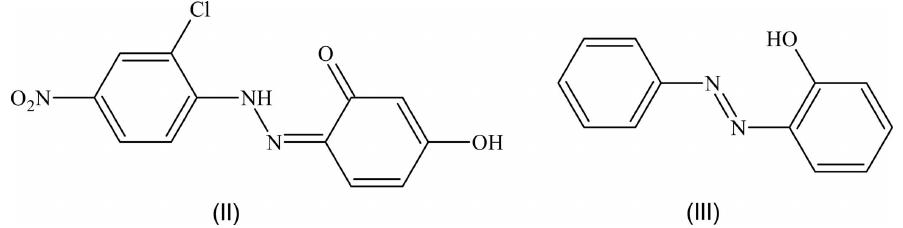
The molecular structure of the title compound with atomic labels and 50% probability displacement ellipsoids for non-H atoms.